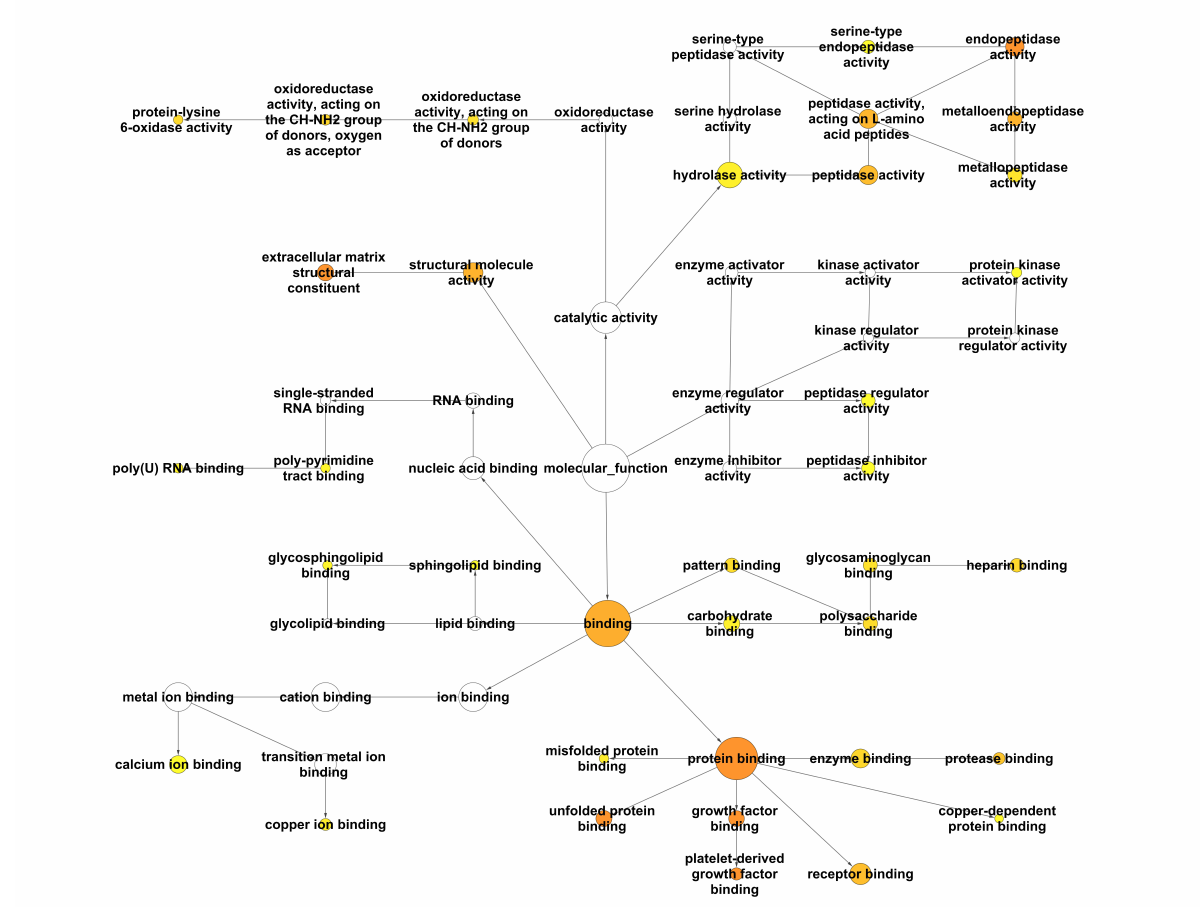
Figure 5. Analysis of the LOX family interactome with BiNGO for the GO term “Molecular Function”. For each GO term category, BiNGO provides a layout of interconnected and colored circles corresponding to each annotation. The circle diameter indicates the number of proteins annotated by a GO term. The yellow to orange color gradient is correlated to the p -value ( p < 0.01), the more significant terms being colored